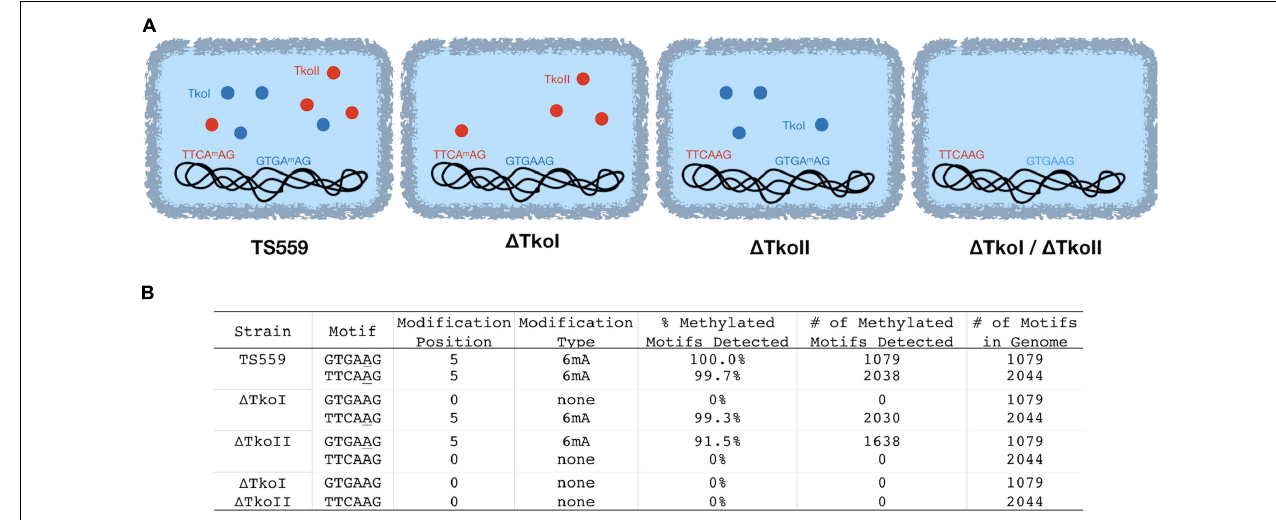
FIGURE 2 | TkoI and TkoII methylate single strands of defined DNA motifs in vivo . PacBio SMRT sequencing was used to sequence genomic DNA from four T. kodakarensis strains (TS559, (cid:49) TkoI, (cid:49) TkoII, and (cid:49) TkoI/ (cid:49) TkoII). (A) T. kodakarensis strains are schematically illustrated with TkoI (blue) and TkoII (red) and detected modification motifs in each strain are highlighted. (B) After sequencing, PacBio Modification and Motif software identified sequence motifs that were modified in each strain.